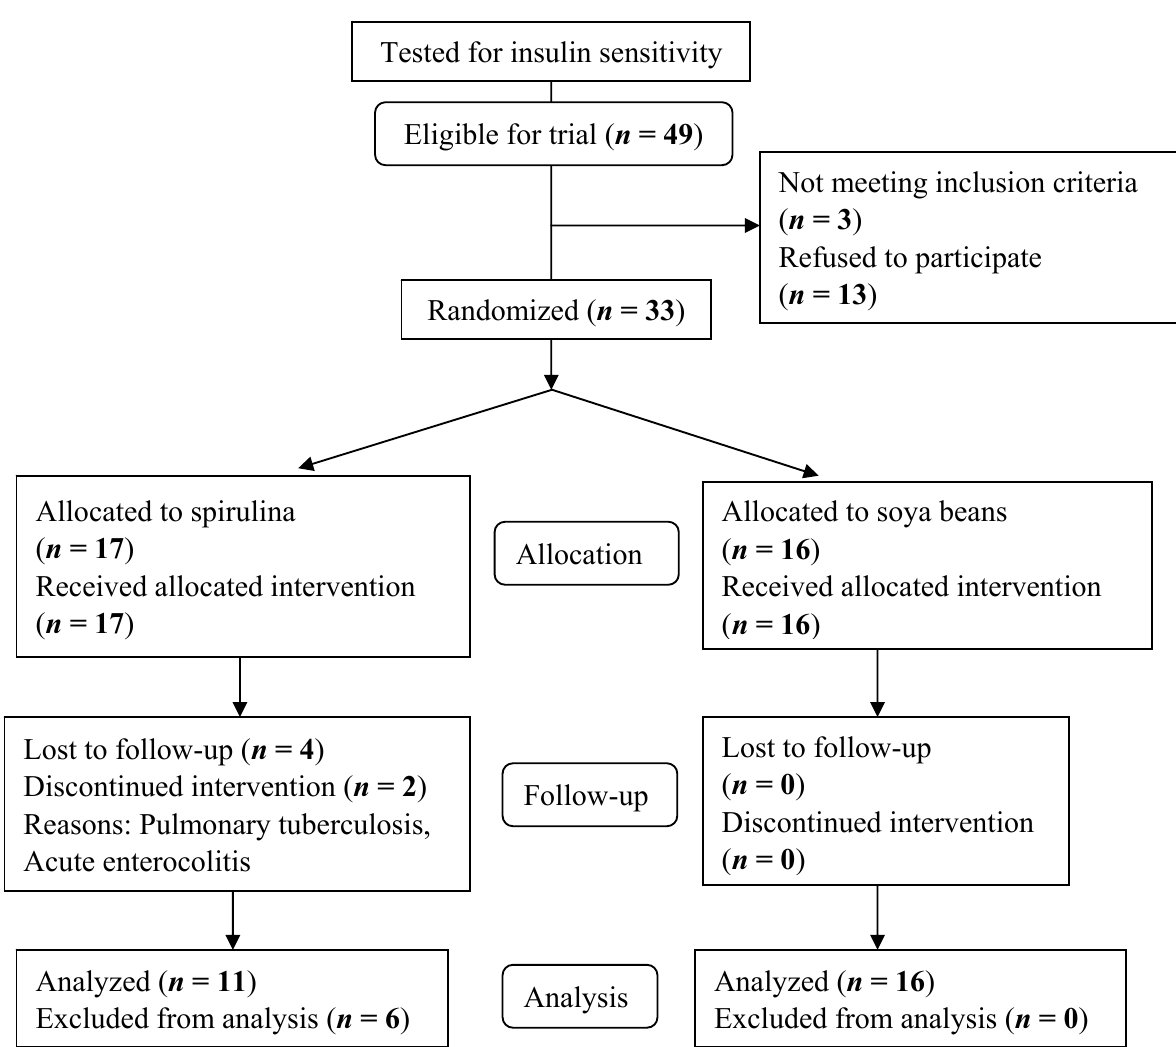
Figure 1. Participant flow in the course of the